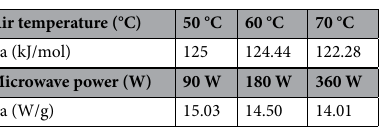
Table 4. The estimated activation energy in convective and microwave